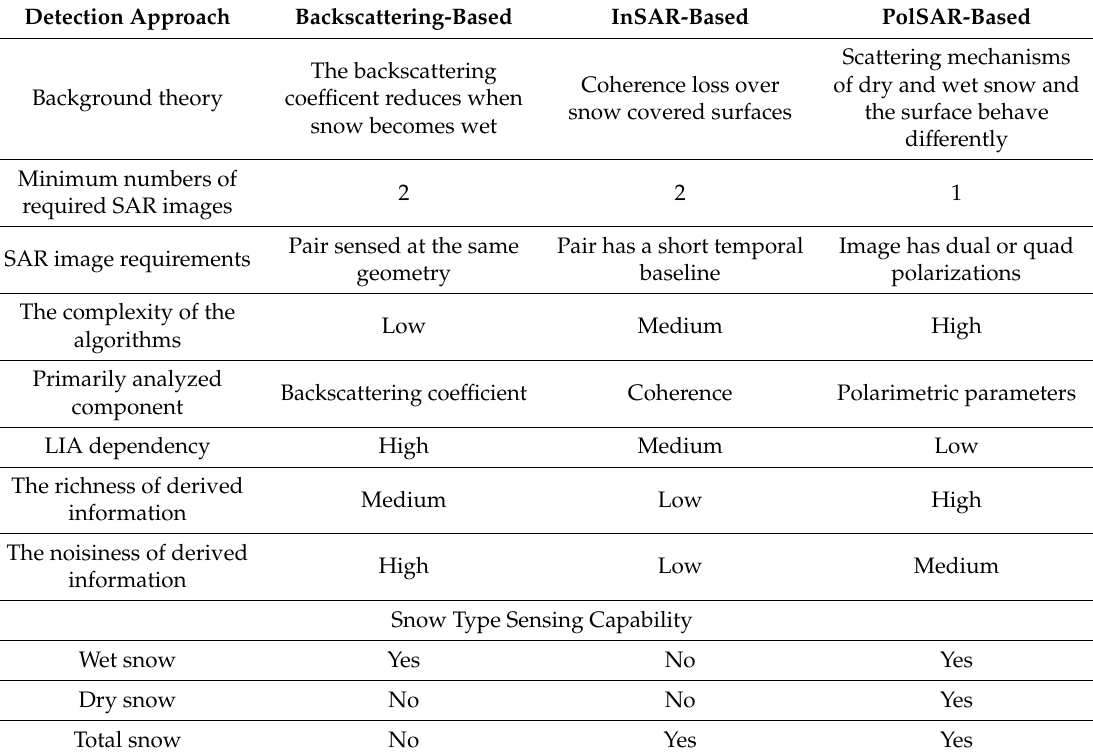
Table 3. Overall comparison of the three mainstream SAR-based snow cover detection approaches. Detection